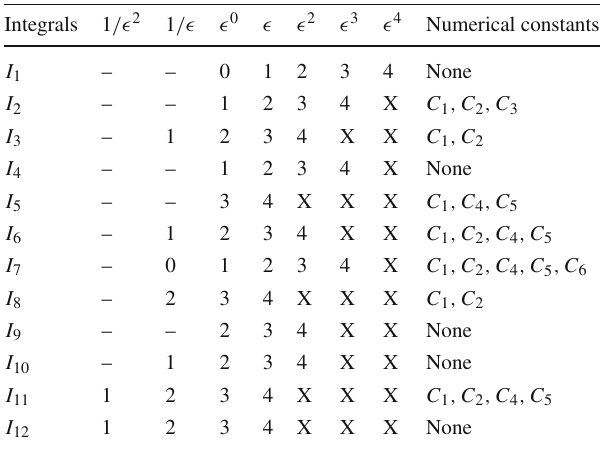
Table 2 This table summarizes the structure of the (cid:3) expansion of the various MIs. The numbers in the table indicate the maximum weight of the GPLs found at a given order of the epsilon expansion. Terms involving GPLs of weight five and higher were not evaluated (except for the case of I 5 , see text) and are indicated with an X in the